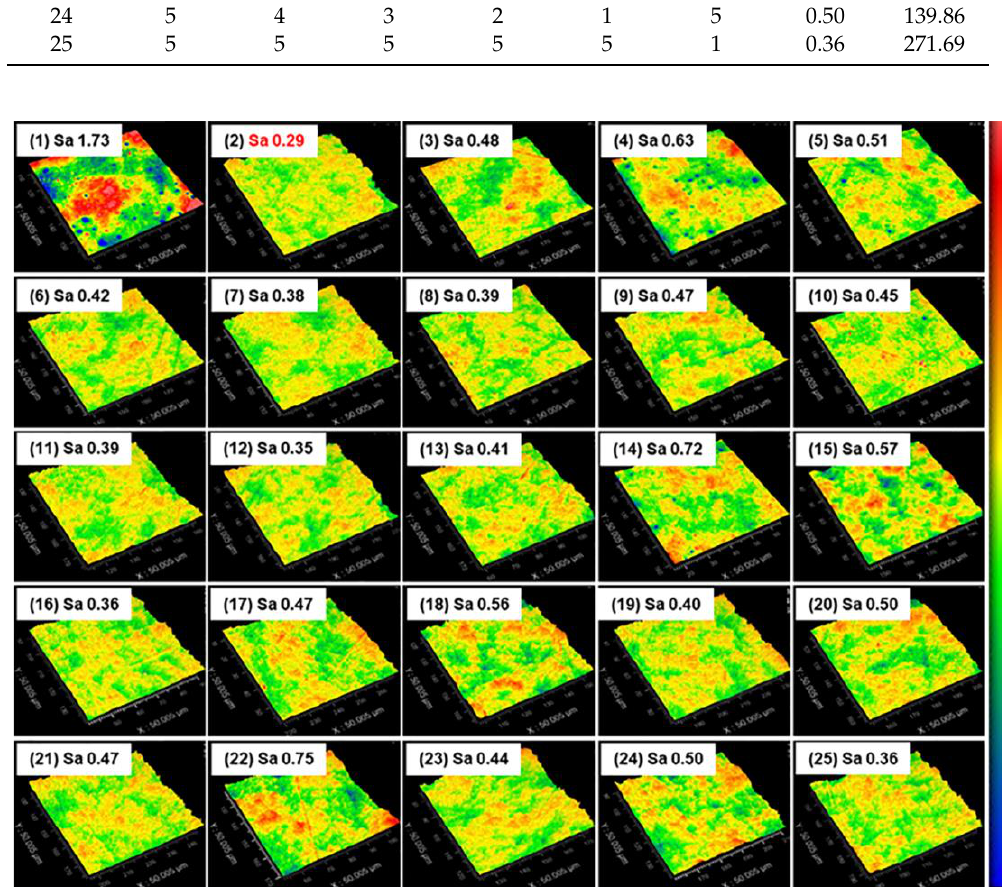
Figure A1. Surface morphology of all samples from the orthogonal experiment.